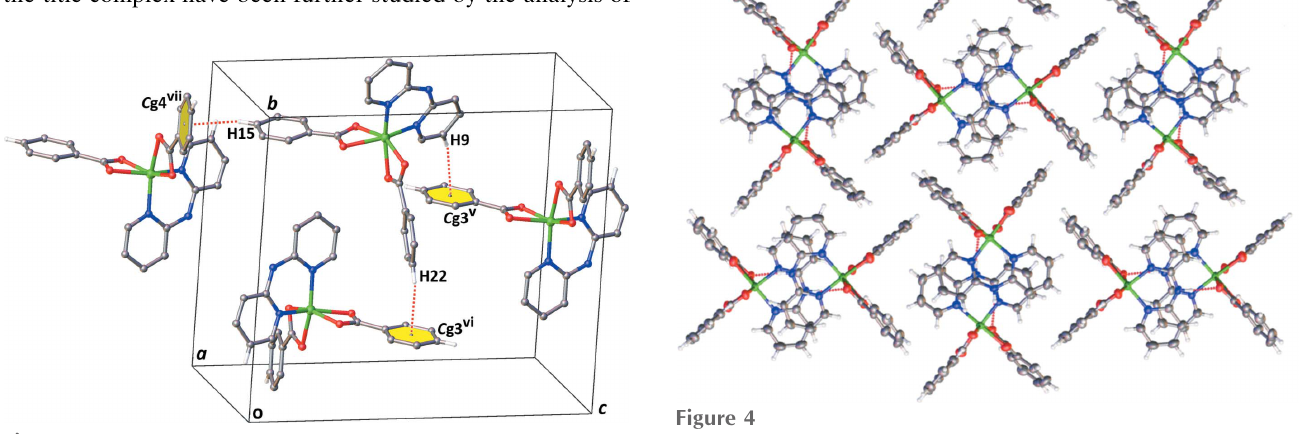
Figure 3 View of the C—H (cid:2)(cid:2)(cid:2) (cid:2) intermolecular interactions of the title complex.